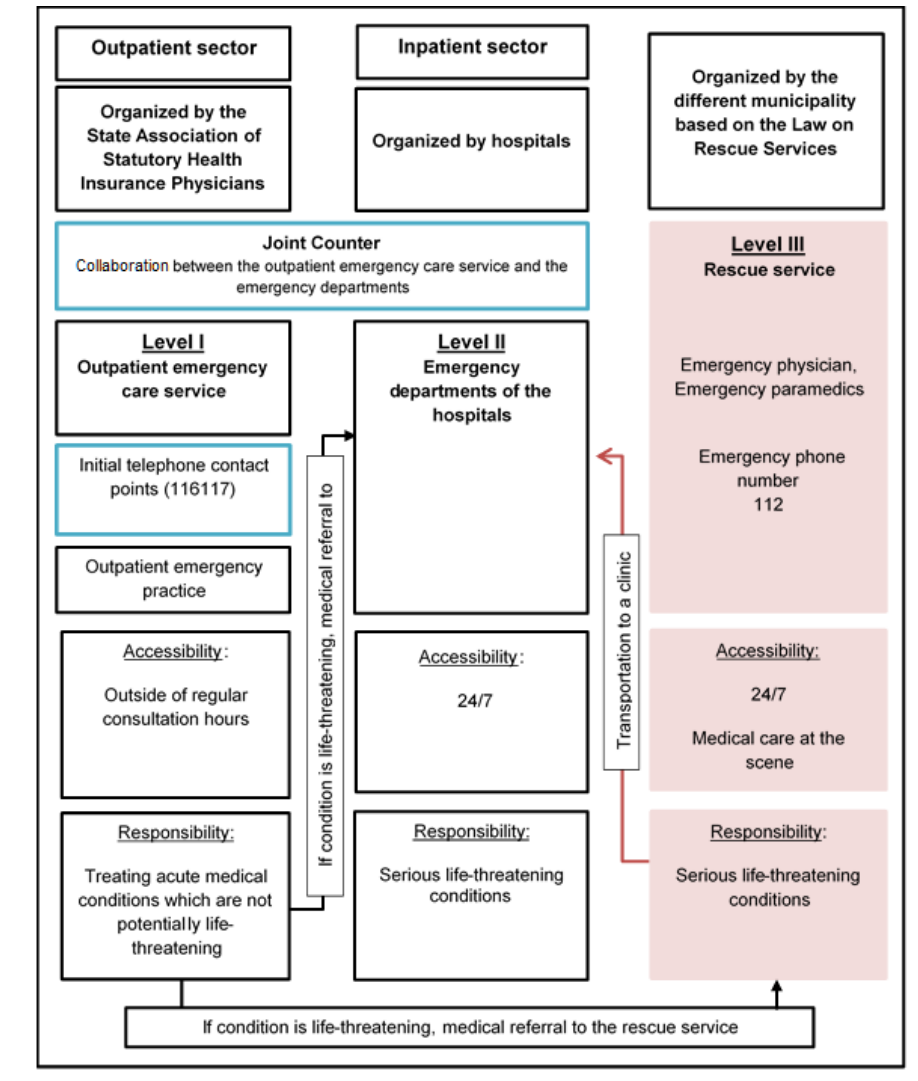
Figure 1. Overview of the three different levels of emergency care in